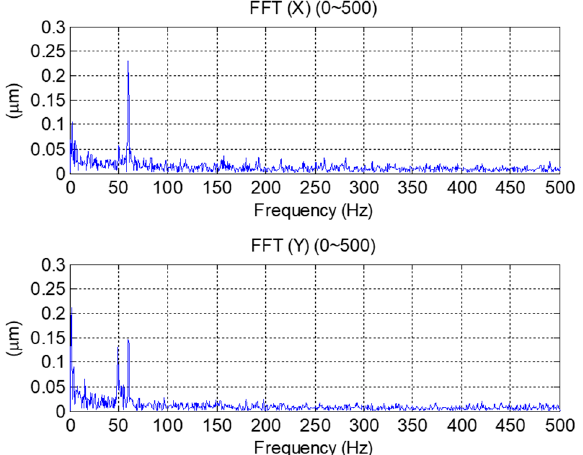
Figure 12. PSD output signals after the low − pass filter was run.